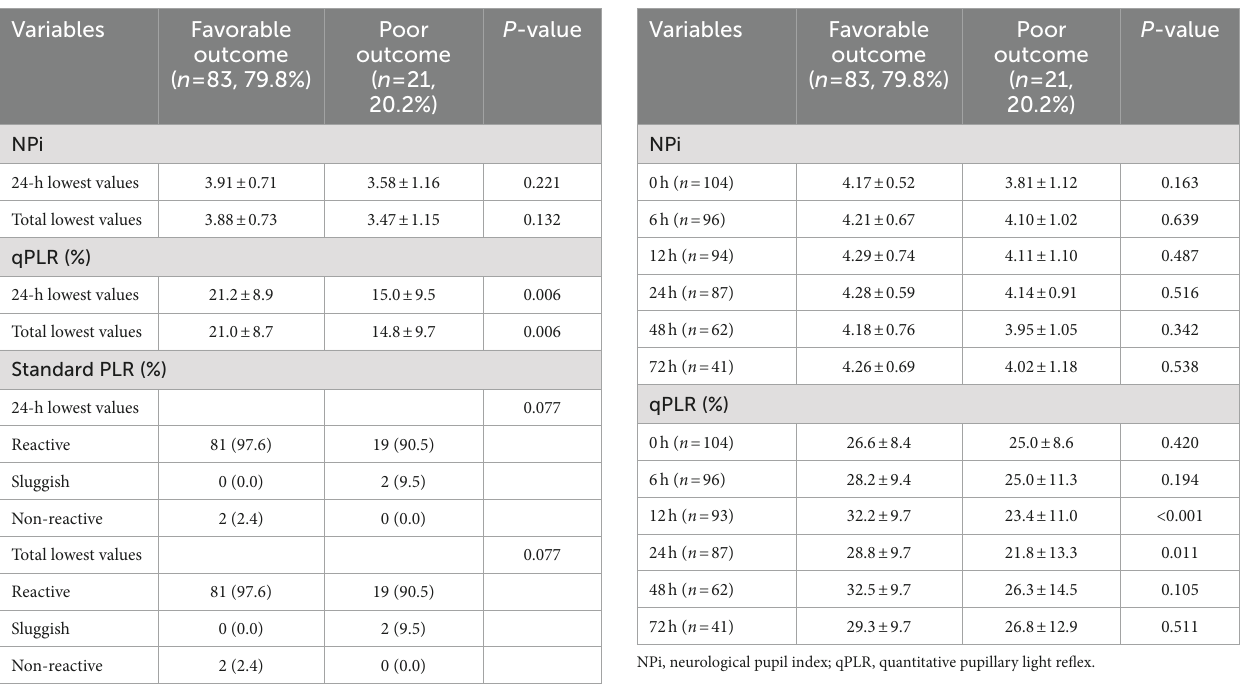
groups. The representative values at 24 h or during the whole monitoring time did not differ between patients with favorable outcomes and those with poor outcomes. However, the patients with poor outcomes had a significantly lower constriction velocity and worse maximum constriction velocity during the whole monitoring time compared to those with favorable outcomes (median, 0.79 vs. respectively; Supplementary Table S2). ROC analysis was performed to compare pupillometer data in predicting neurocognitive outcome at 1 month (Table 4). The AUC value was 0.70 for qPLR [(95% confidence interval (CI): 0.60–0.78)],